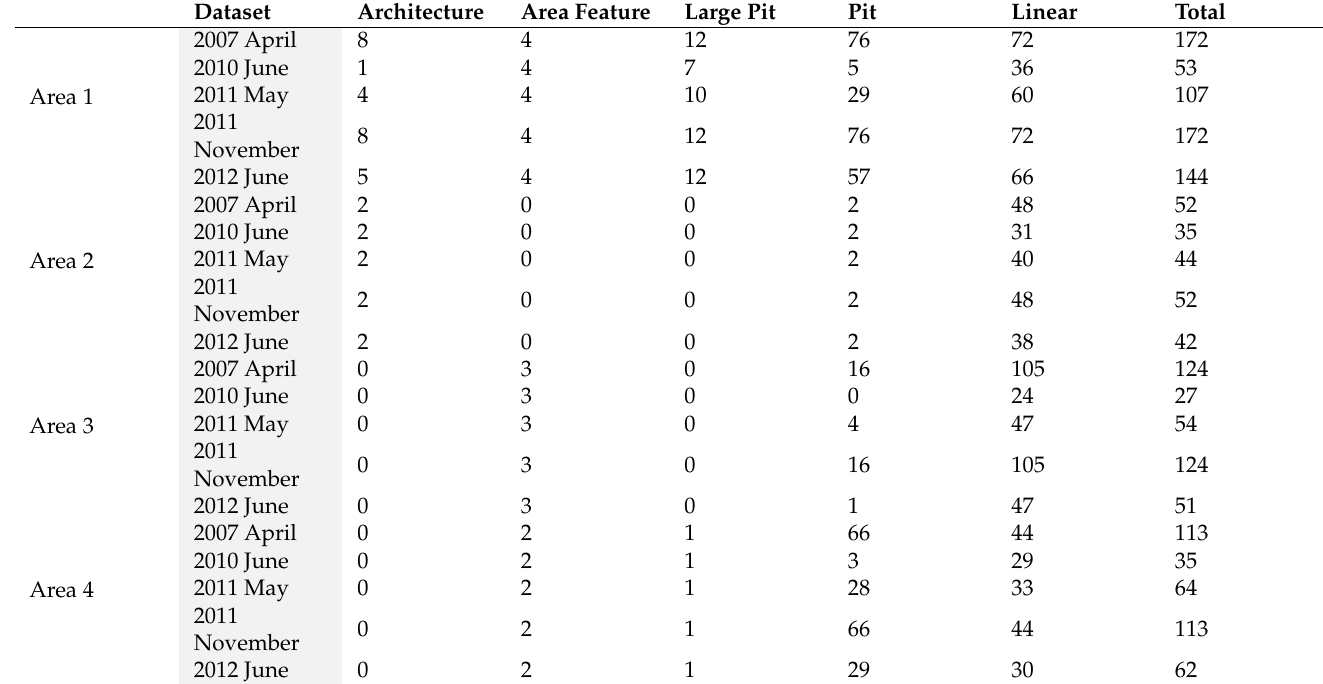
Table 4. Numbers of individual features from each “copied interpretation”